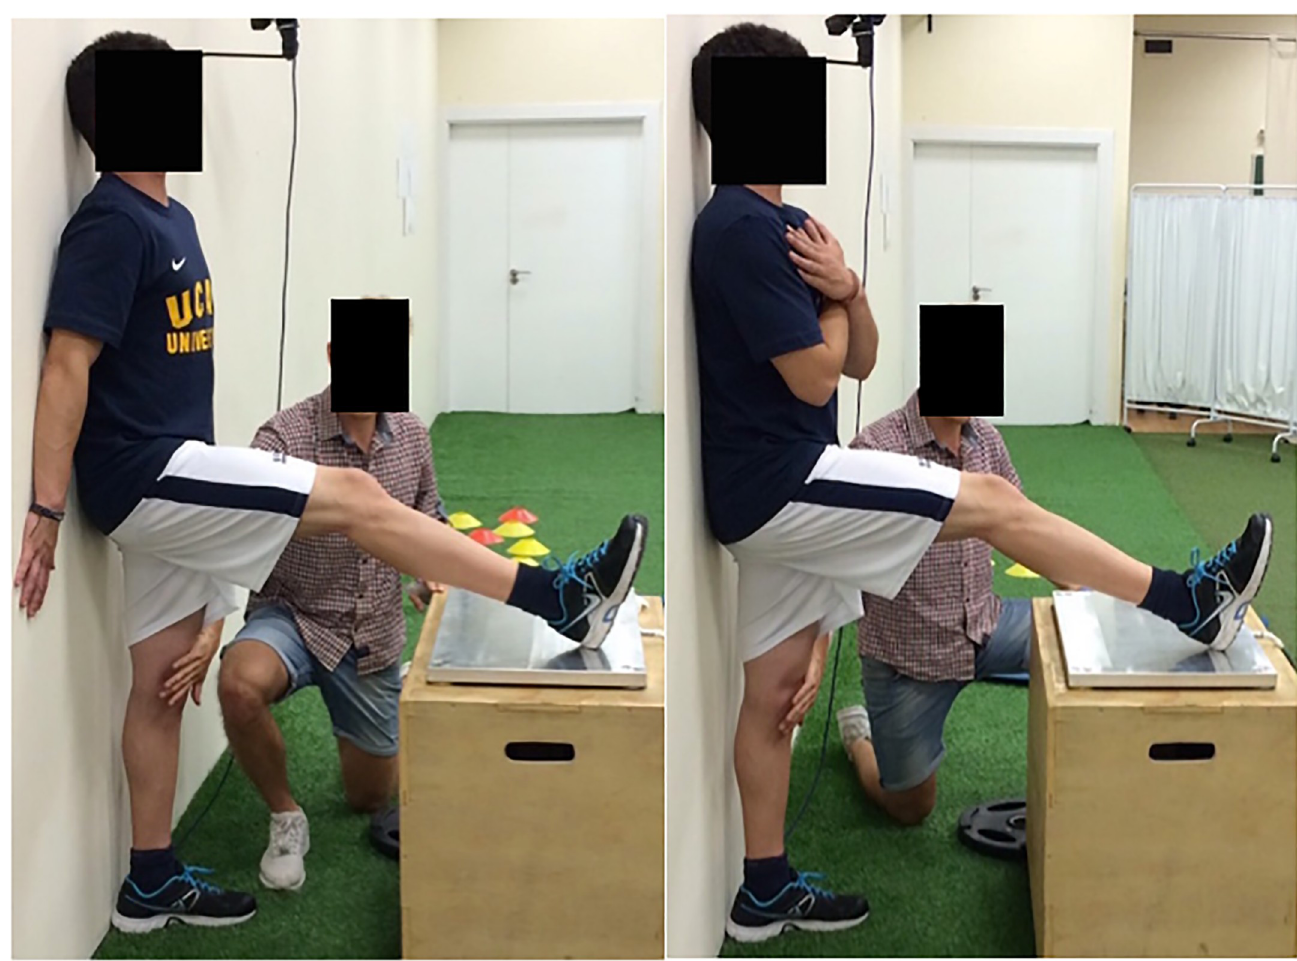
Fig 1. 90˚:20˚ protocols. (a) with hands crossed on chest (HC) (b) with hands against the wall